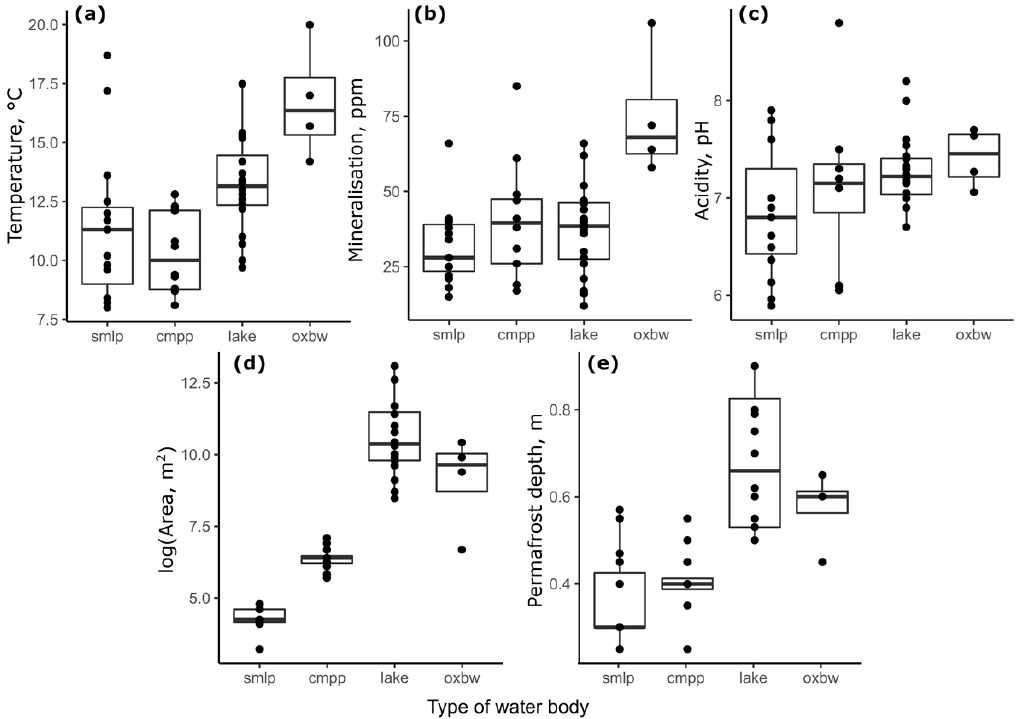
Figure 2. Variation in environmental characteristics ( а is temperature, °C; b is total mineralization, ppm; c is acidity, pH; d is log (area, m 2 ); e is permafrost depth, m) in relation to the type of the water body. (Abbreviations: smlp—single polygonal ponds; cmpp—complex polygonal ponds; lake— large thermokarst lakes; oxbw—oxbows.) Table 1. The total species number of ecological groups in various types of water bodies in the Lena River Delta.